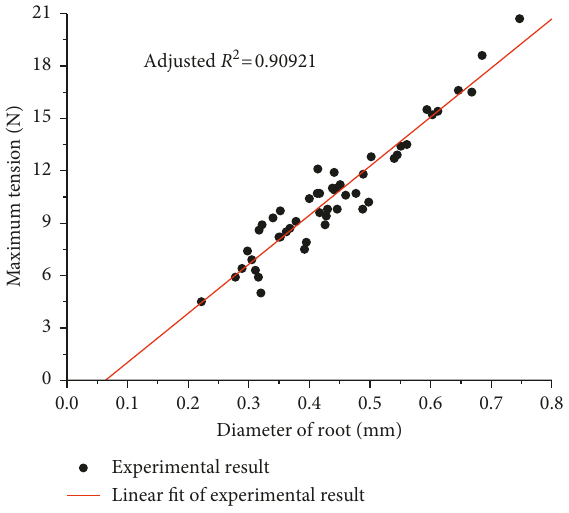
Figure 15: Result of stretching test.